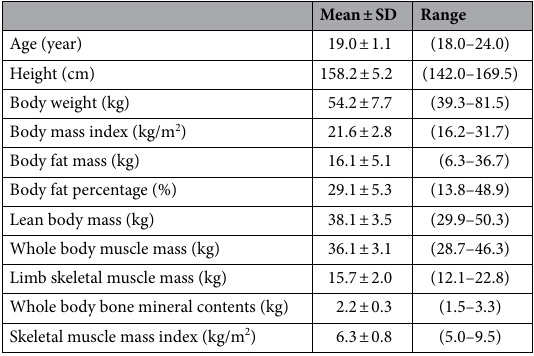
Table 1. Characteristics of